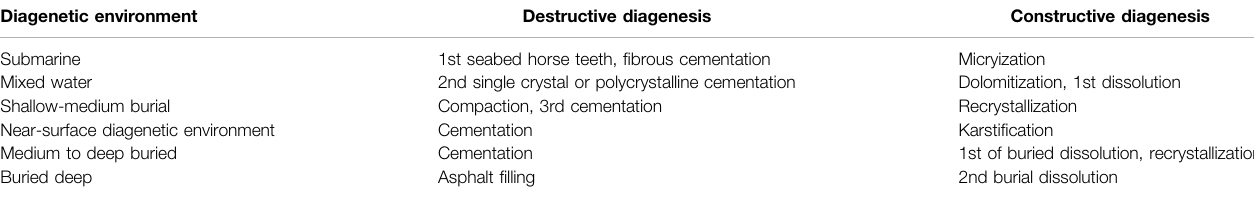
TABLE 2 | Summary of the main diagenetic environment of Cambrian reservoirs in the Sichuan Basin — diagenesis — diagenesis